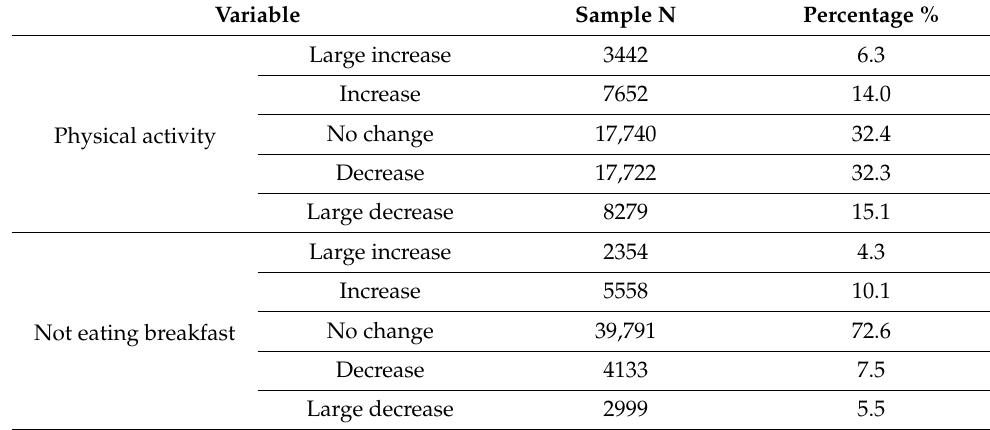
Table 5. Changes in daily life due to the COVID-19